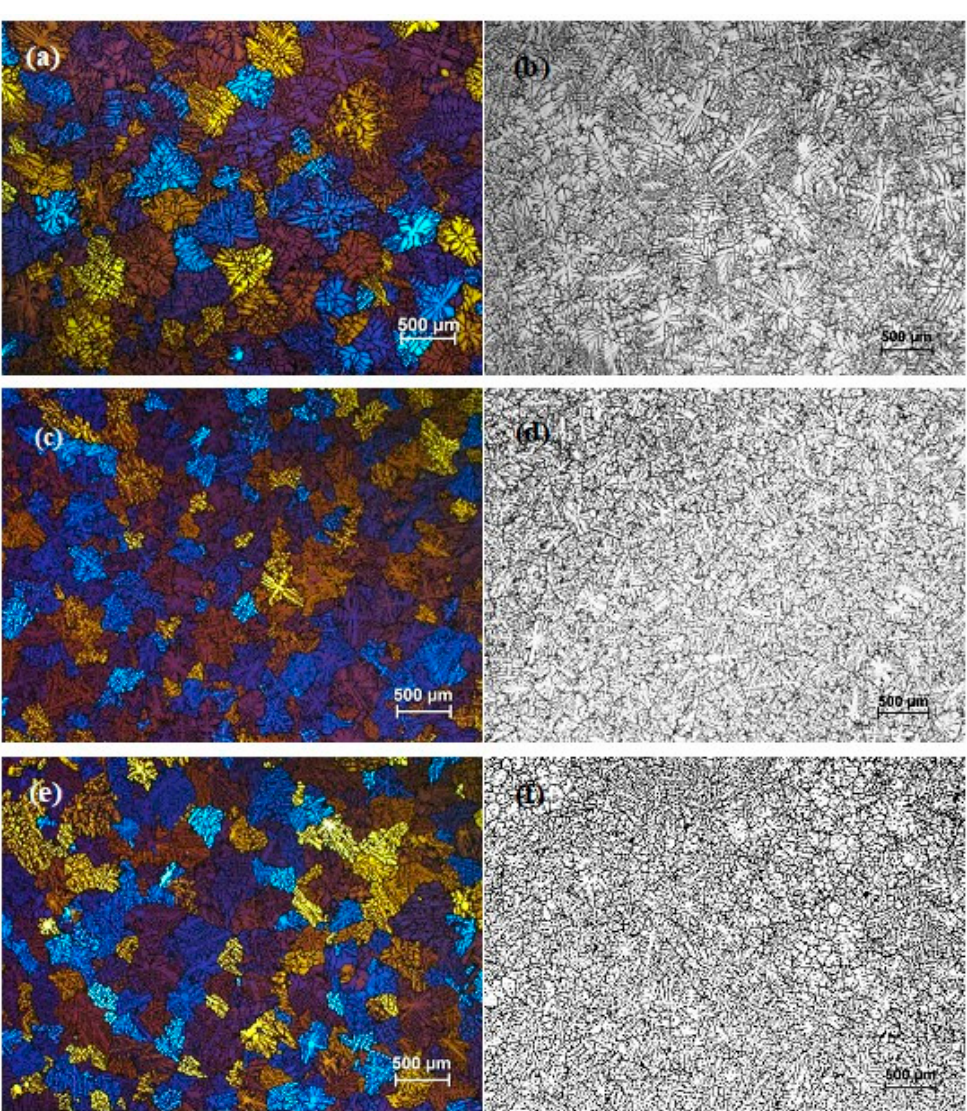
Figure 5. Optical micrographs of direct chill cast billets of bottom ash BA-6111, samples were sectioned from the central portion of DC, DC-GR and MC-DC cast billets. ( a , b ) DC without GR, ( c , d ) DC with GR, and ( e , f ) MC-DC without GR.